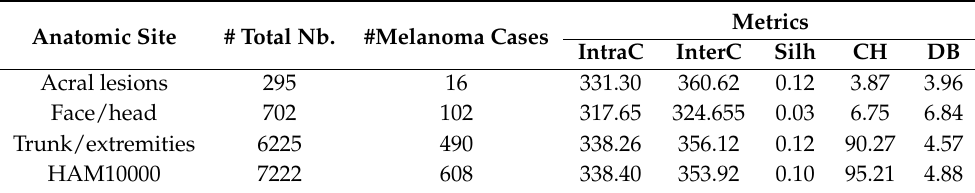
Table 2. Statistical analysis of the dataset including calculations for the entire HAM10000 dataset regarding malignant and benign lesions as well as distribution in the acral and non-acral subsets. Anatomic Site # Total Nb.